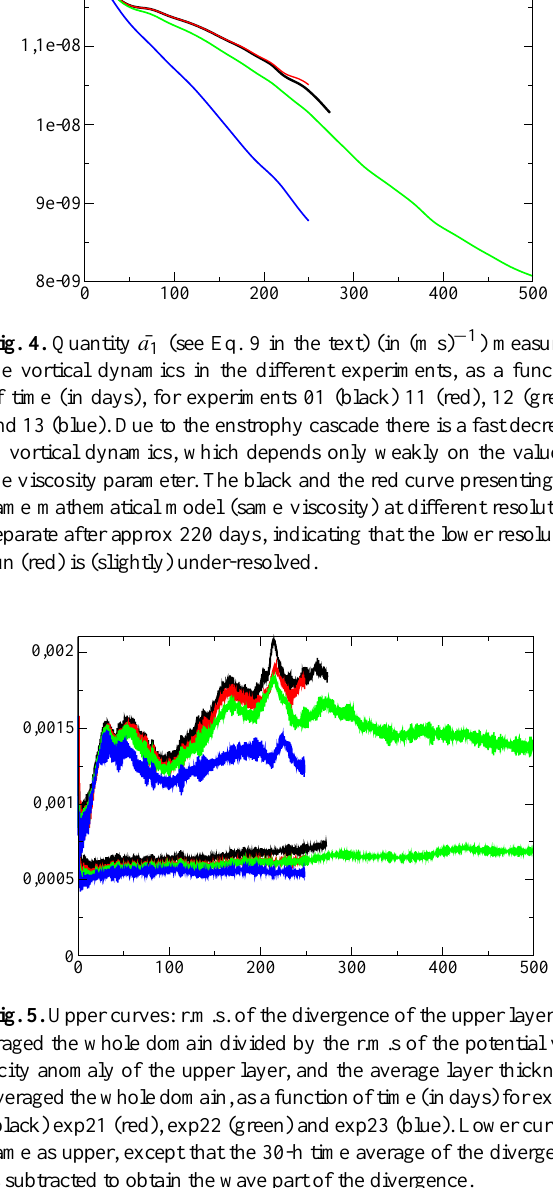
Fig. 4. Quantity ¯ a 1 (see eq. (9) in the text) (in ( ms ) − 1 ) measuring the vortical dynamics in the different experiments, as a function of time (in days), for experiments 01 (black) 11 (red), 12 (green) and 13 (blue). Due to the enstrophy cascade there is a fast decrease in vortical dynamics, which depends only weakly on the value of the viscosity parameter. The black and the red curve presenting the same mathematical model (same viscosity) at different resolution, separate after approx 220 days, indicating that the lower resolution run (red) is (slightly) under-resolved.